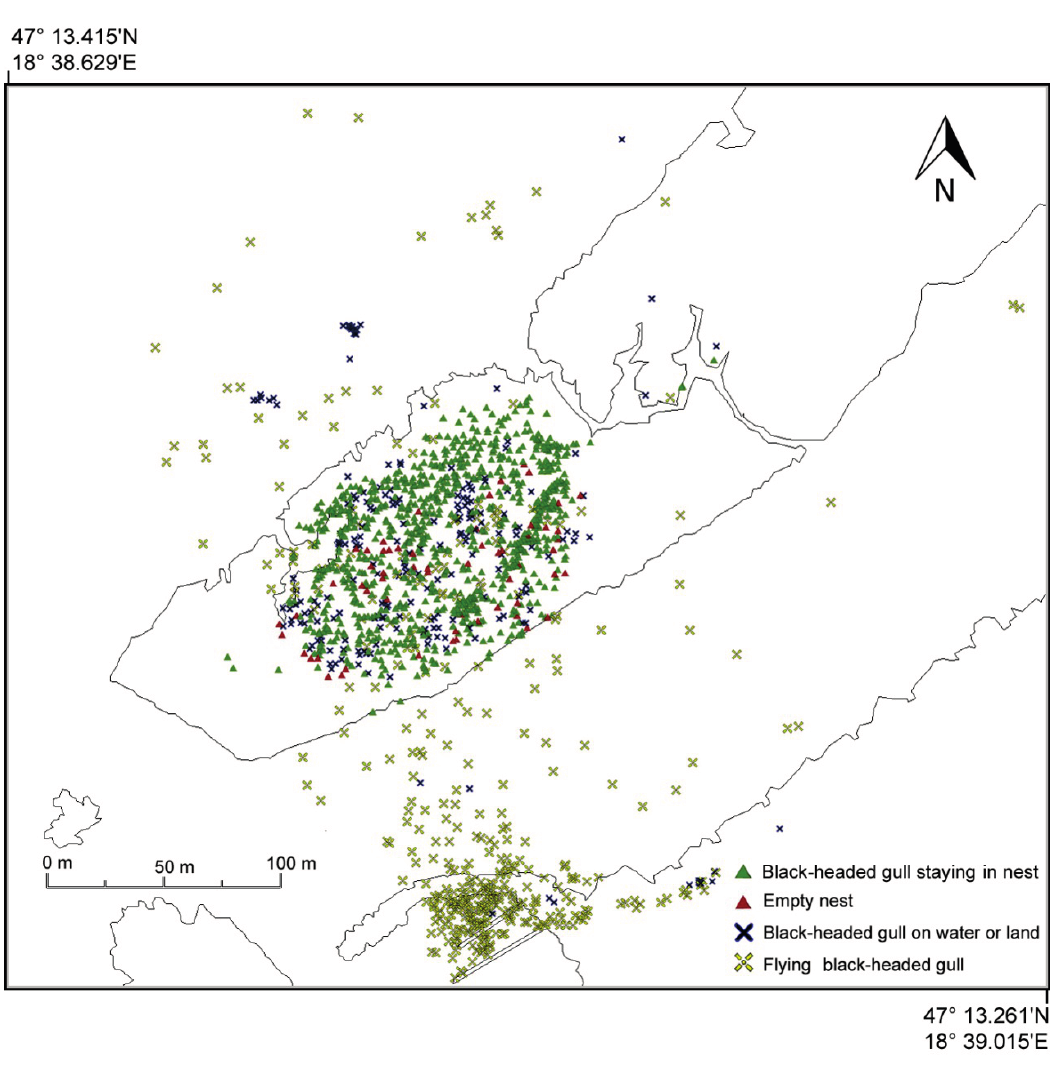
Figure 12. Evaluated black-headed gull